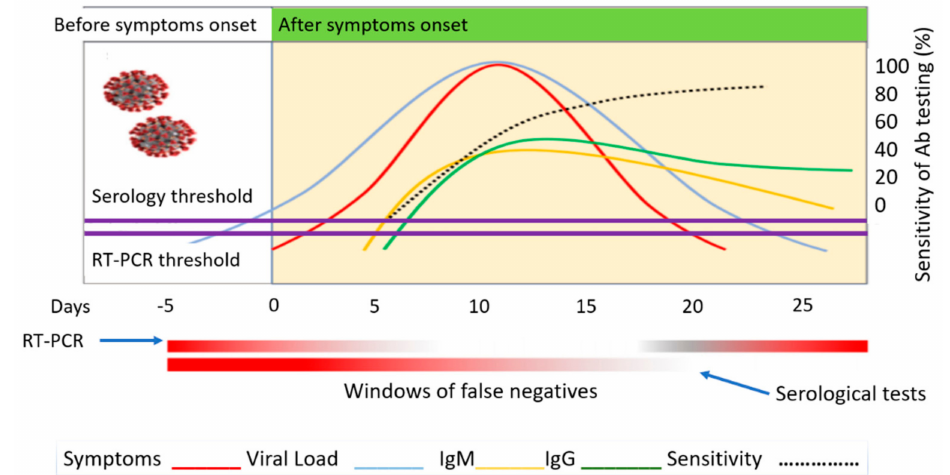
Figure 1. COVID-19 biomarker detection levels over